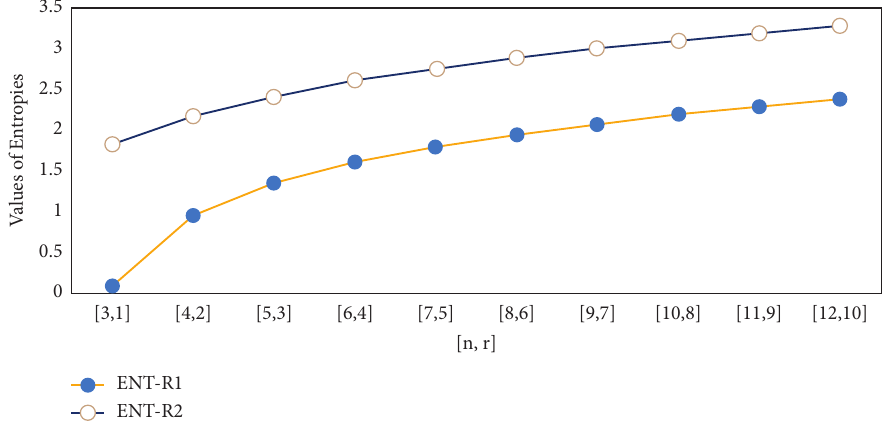
Figure 4: Comparison of Randic entropies for α � 1 and for α � − 1.